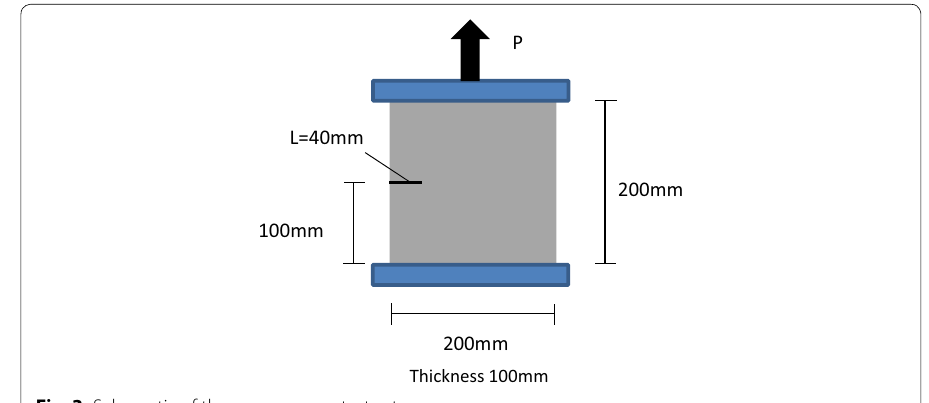
Fig. 3 Schematic of the convergence test set